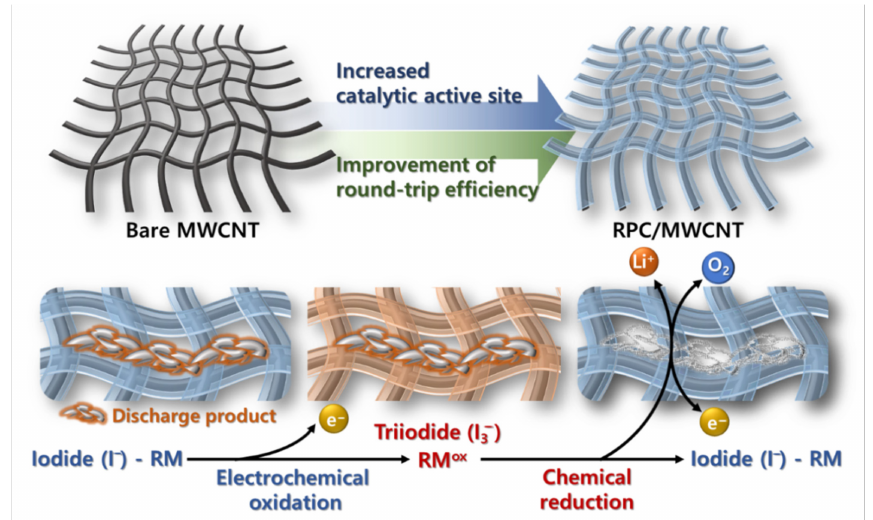
Figure 1. Schematic of the redox-mediated polymer catalyst (RPC) as a cathode catalyst for lithium-air batteries